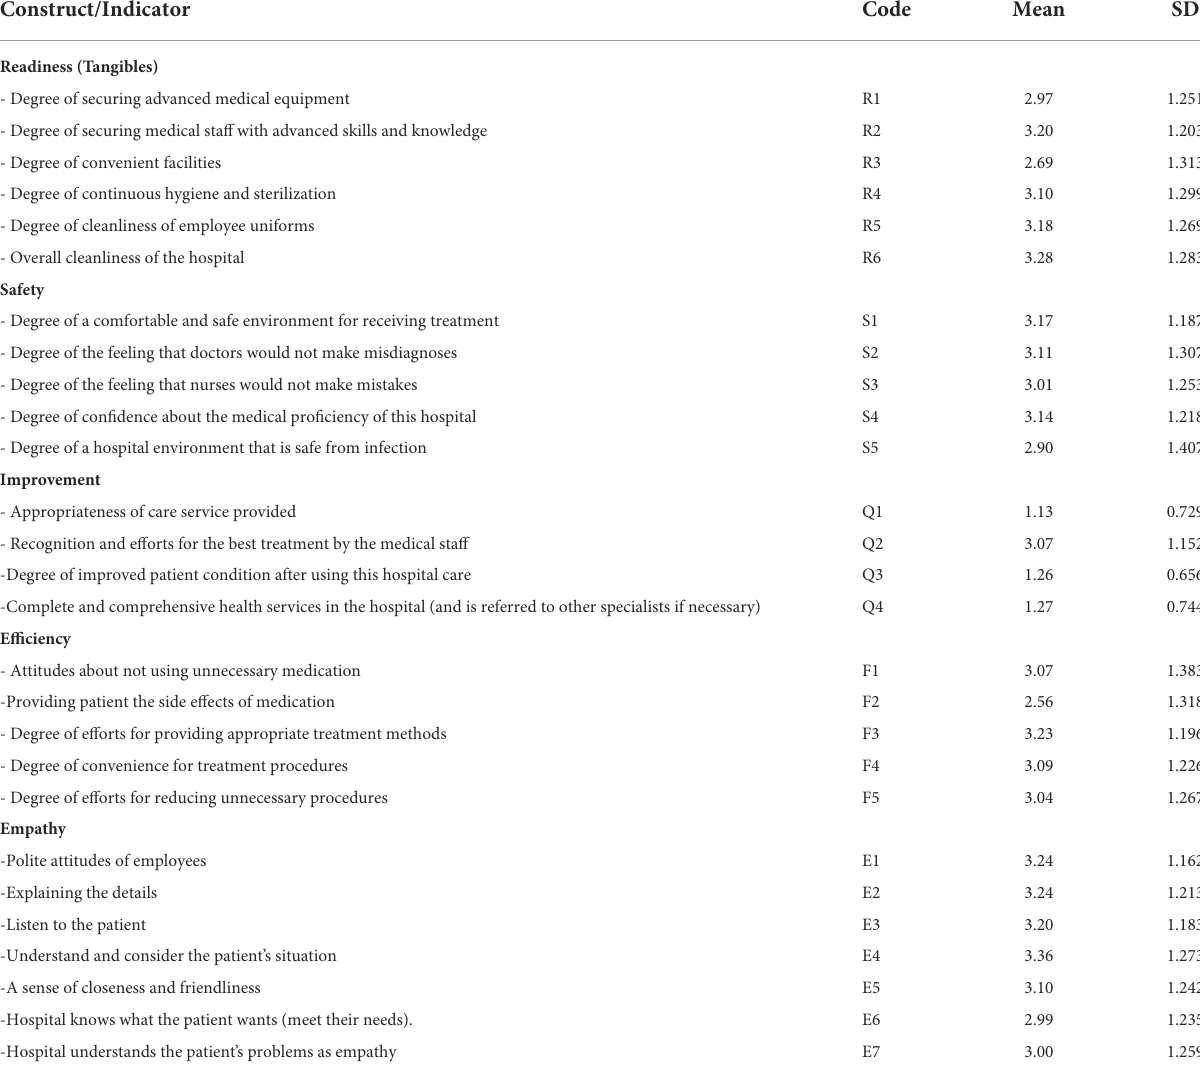
TABLE 2 Measurement items of